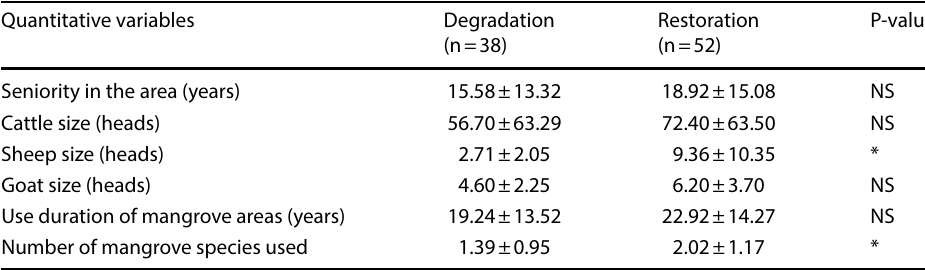
Table 4 Quantitative characteristics of farms around mangroves